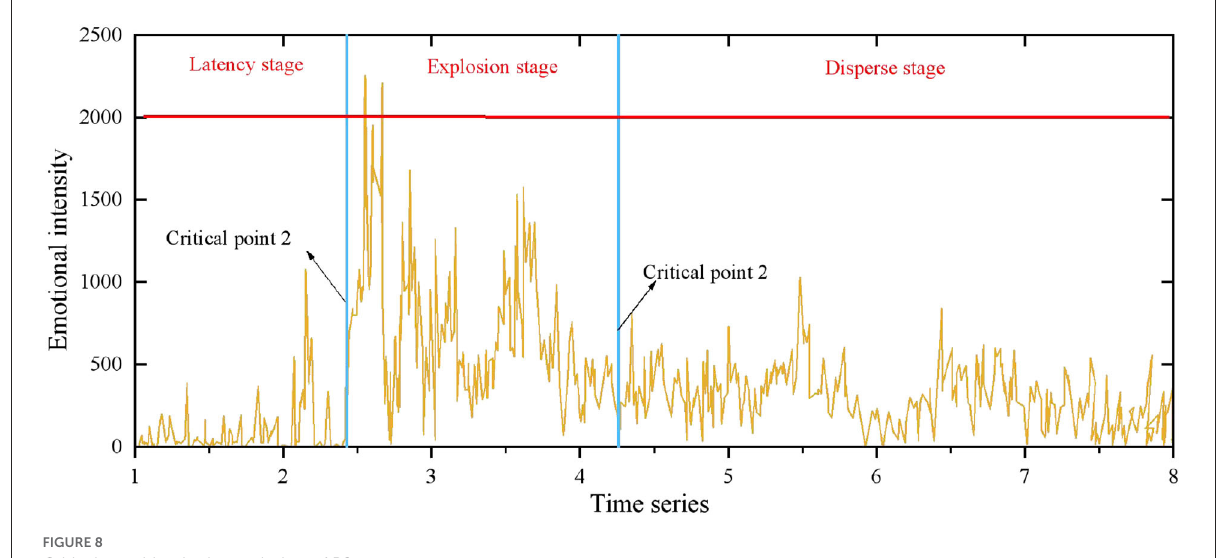
FIGURE8 Critical transition in the evolution of